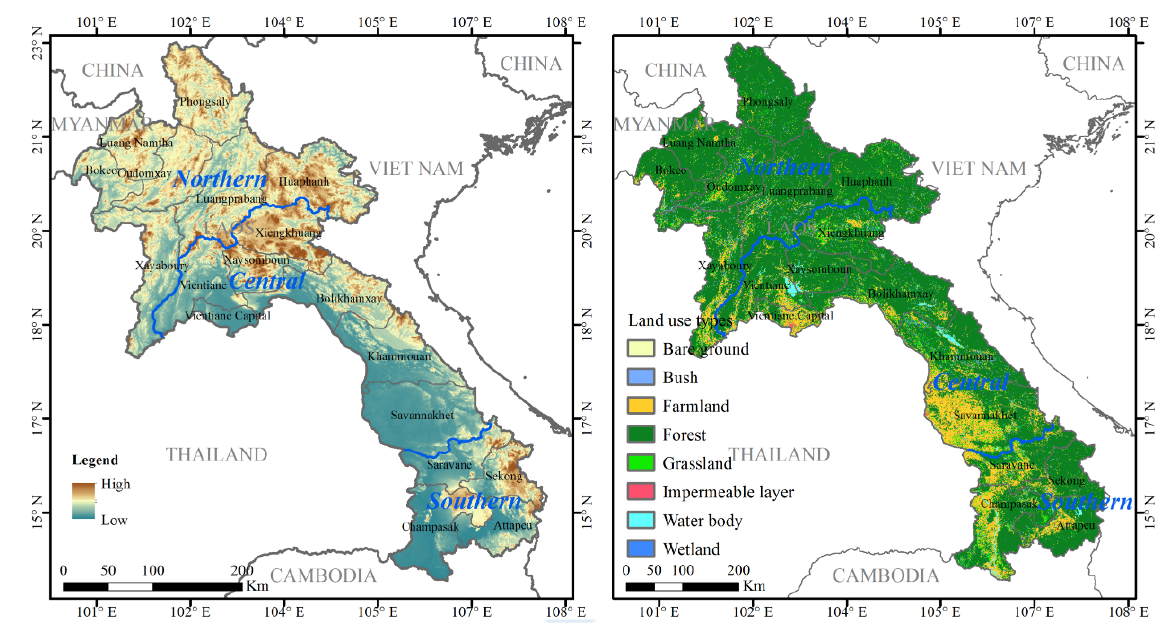
Figure 1. Maps showing the topography and land cover types (2020) in Laos.